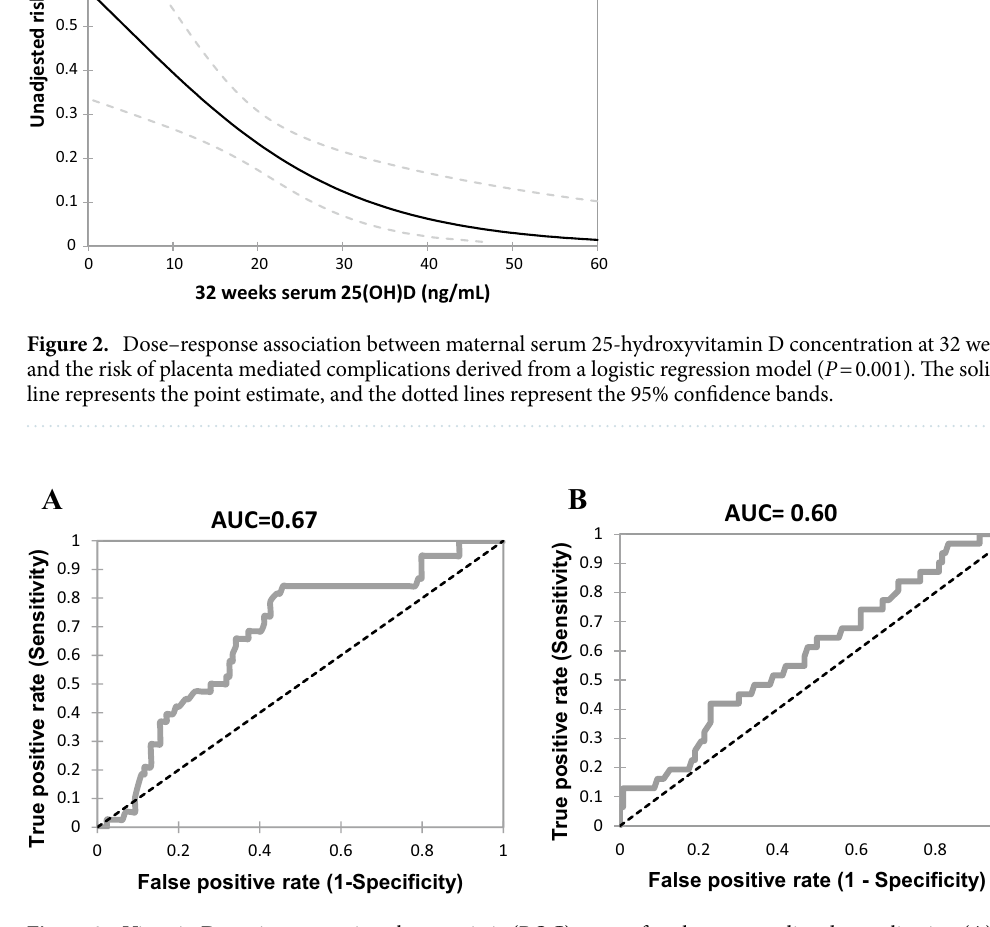
Figure 3. Vitamin D receiver operating characteristic (ROC) curves for placenta-mediated complication ( A ) at 32 weeks ( B ) at 36 weeks. AUC area under the receiver operating characteristic curve.